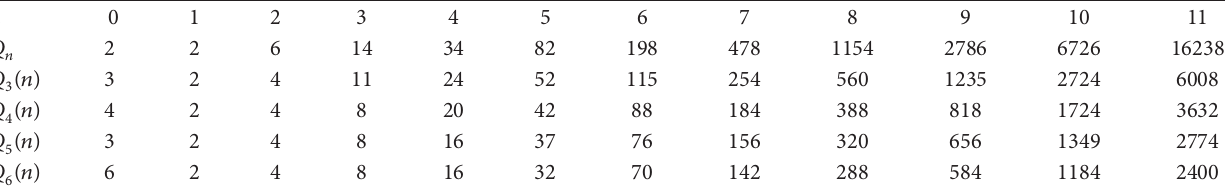
Table 2: The 𝑘 -distance companion Pell sequence 𝑄 𝑘 (𝑛)